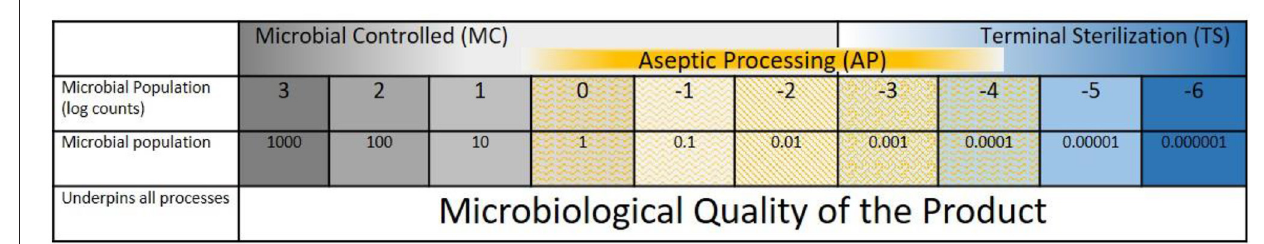
FIGURE 5 | Spectrum of microbiological quality of